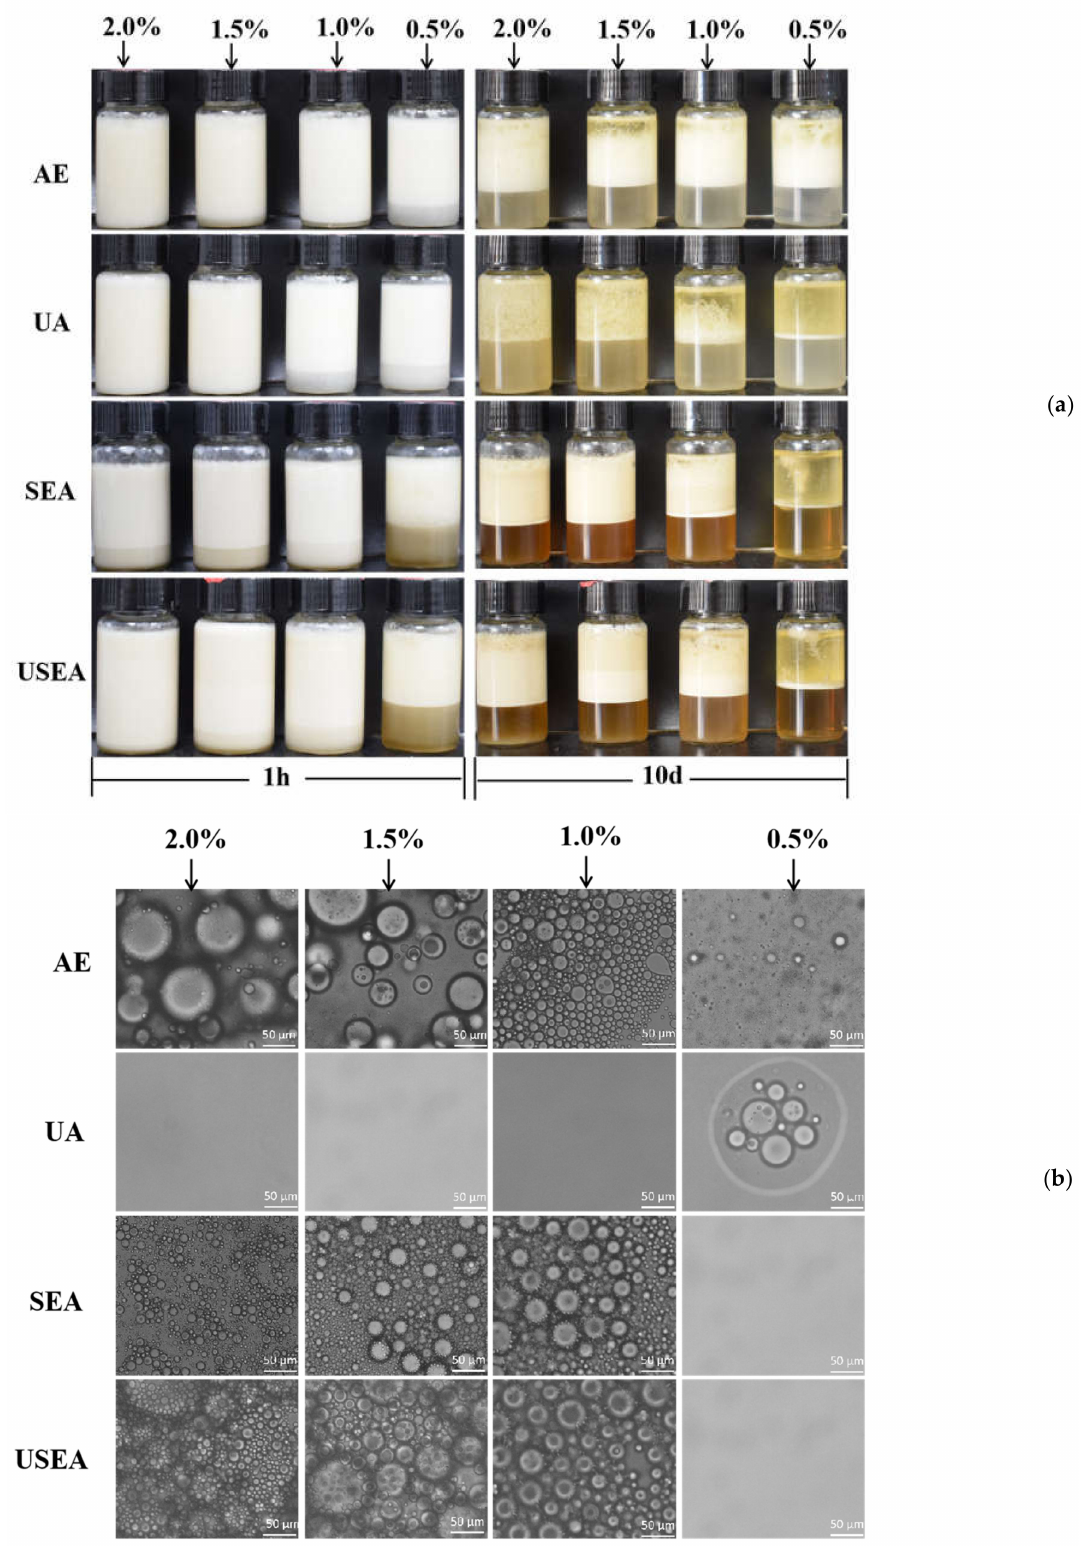
Figure 4. Emulsifying properties of pectin. ( a ) The appearance of emulsions after storage for 1 h and 10 days at room temperature; ( b ) optical microscope images of droplets in the upper layer of the emulsions after storage for 10 days at room temperature ( ×